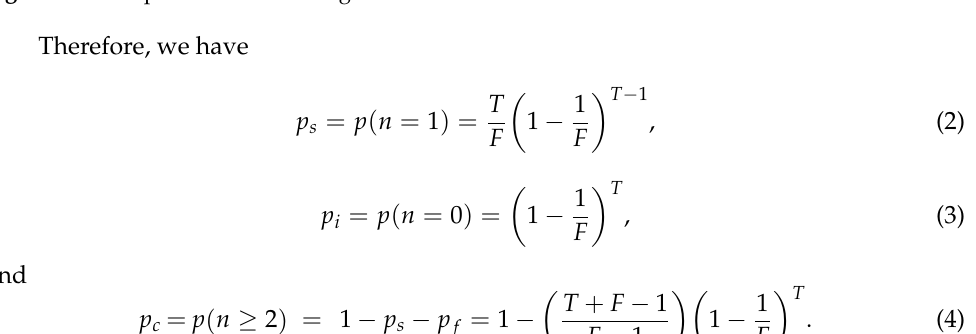
Figure 2. A sample illustration of tag